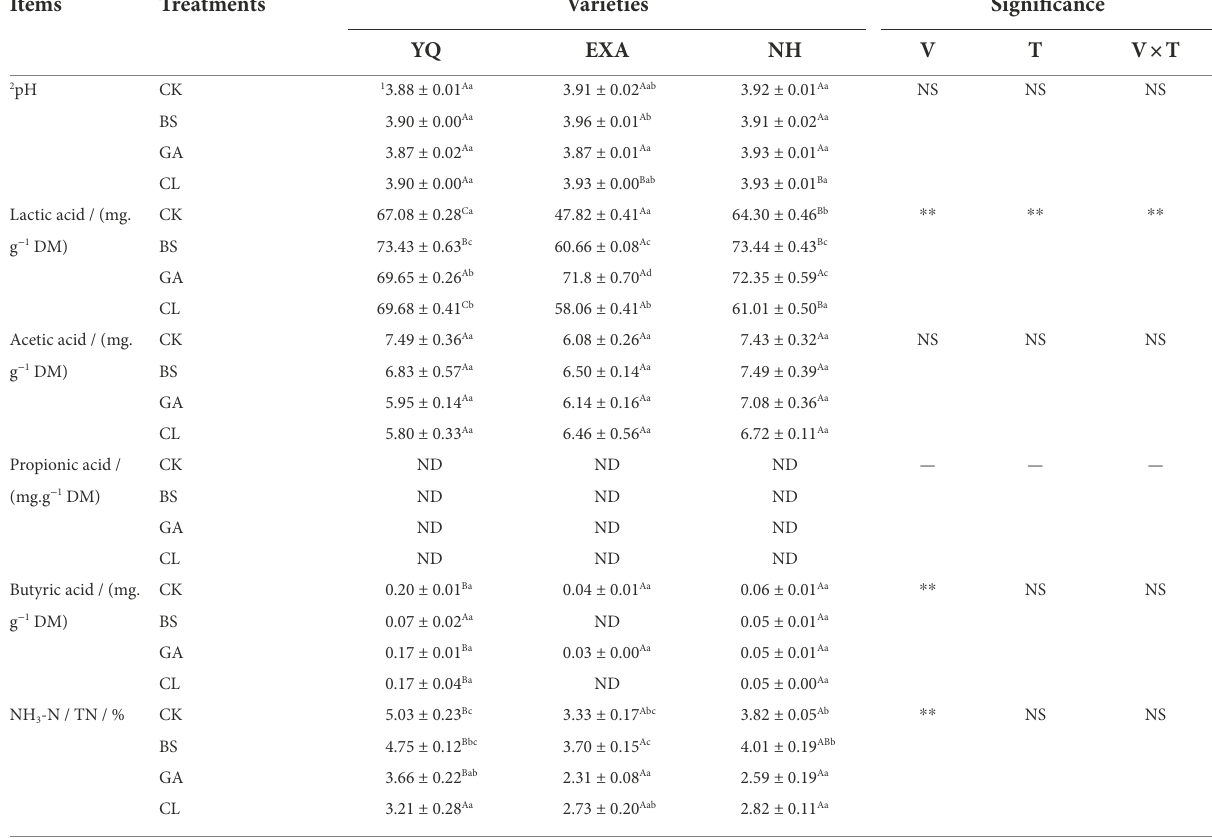
TABLE 4 Effects of varieties and additives on fermentation quality of whole-plant corn silage (±SD, n = 3). Items Treatments Varieties